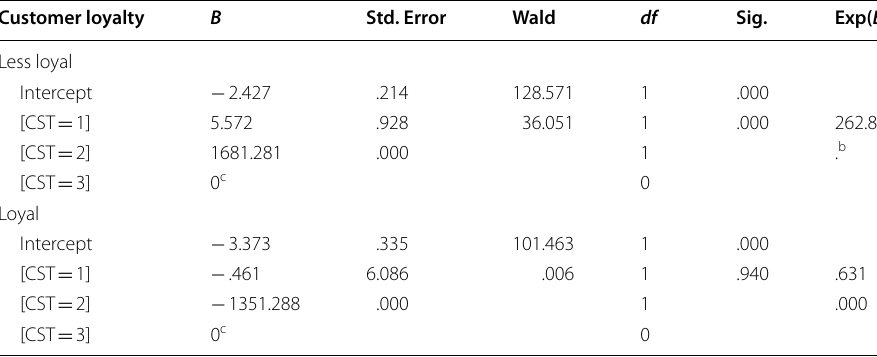
Table 8 Effect of satisfaction on customer